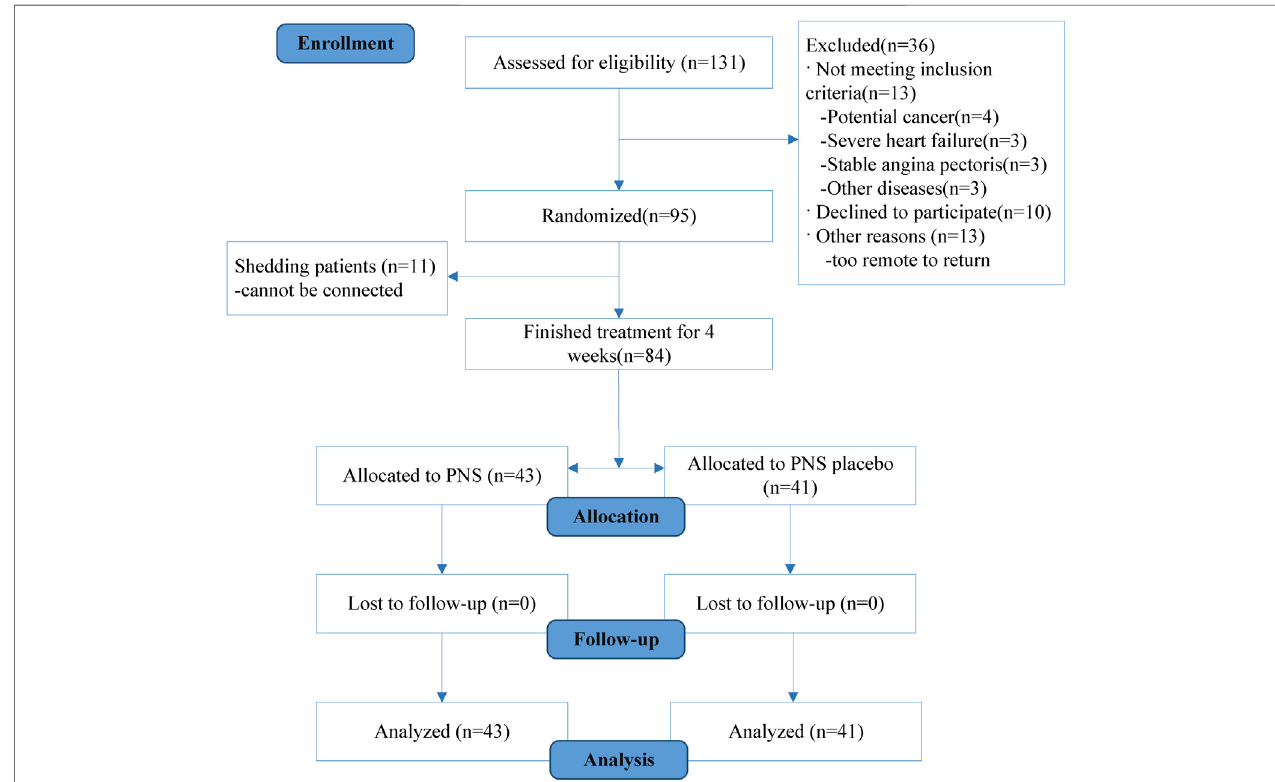
FIGURE 1 | Trial protocol timeline as described in detail in the Materials and Methods section.